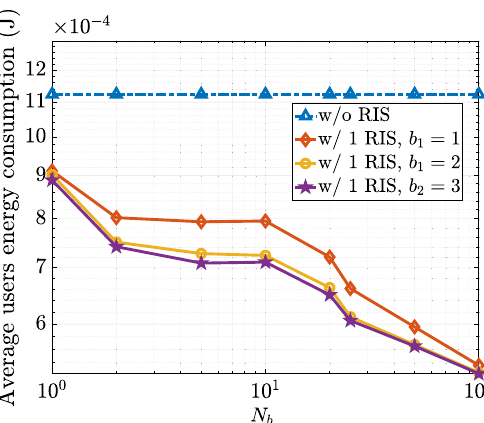
Fig. 7 Average users’ energy consumption vs. N